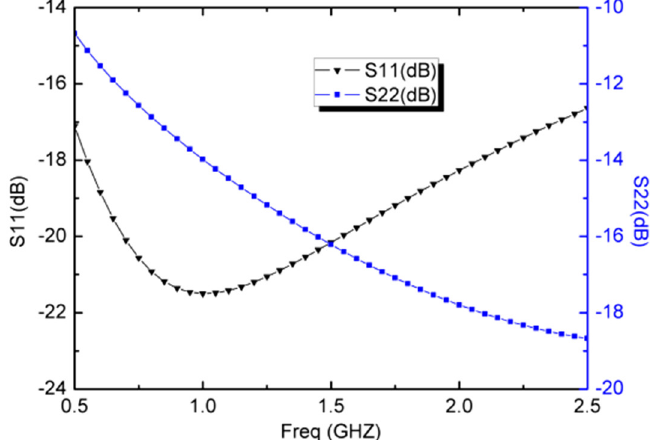
Figure 5. Simulated S11 and S22 of the wideband LNA.